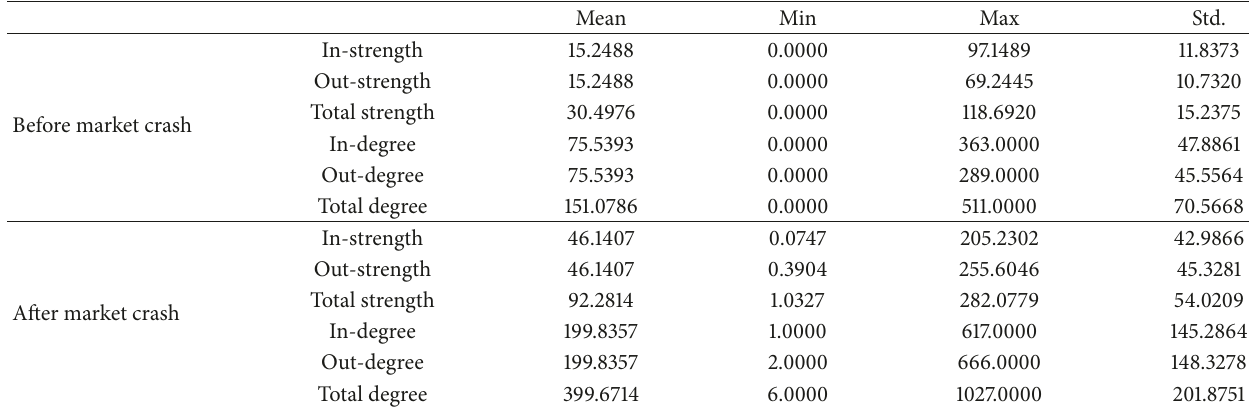
Table 1: Descriptive statistics of network topological